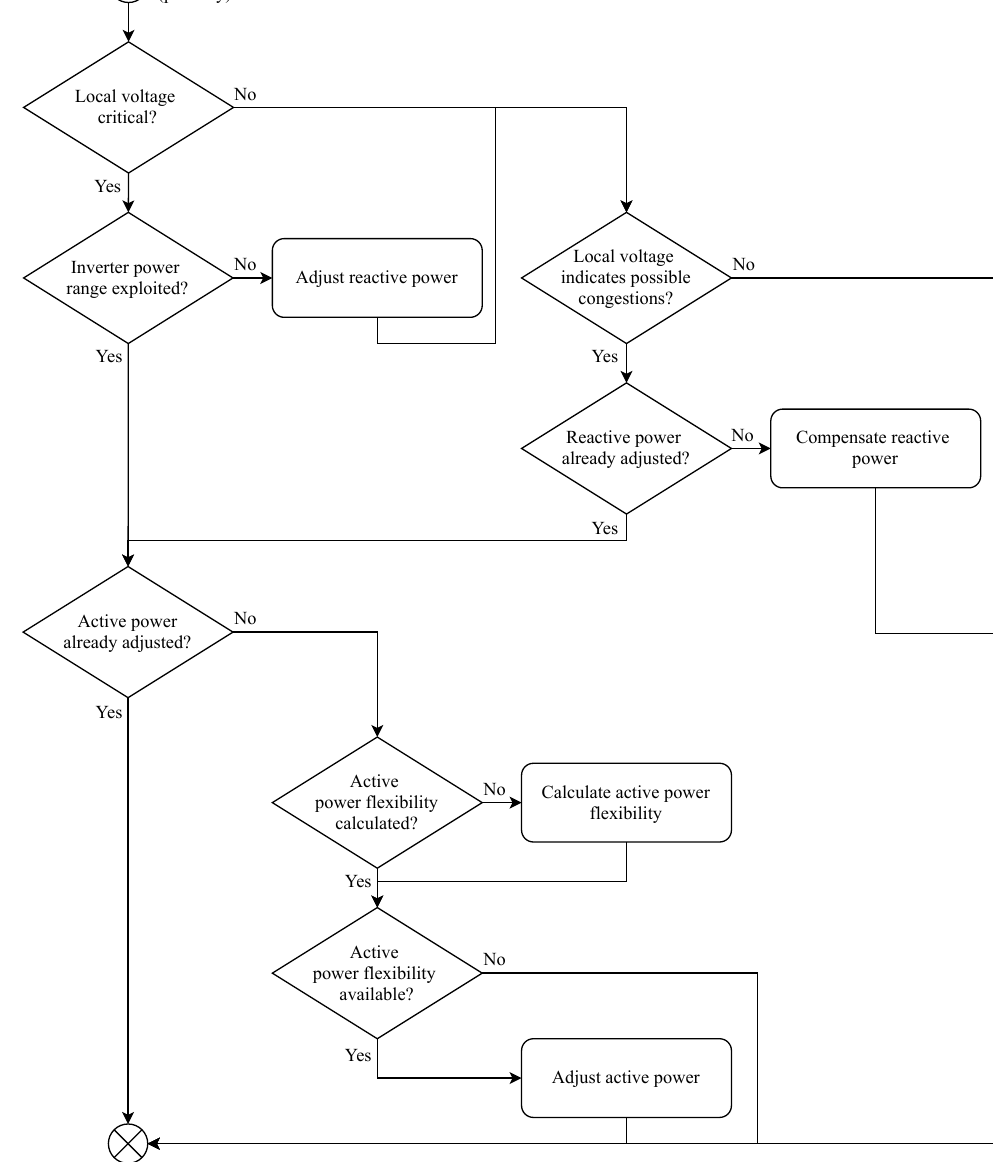
Figure 5. Cascades of measures against critical grid situations employed by each building in the decentralized grid control strategy. While the general cascades of measures are partially adapted from ref. [11], this schematic is new and reflects our specific